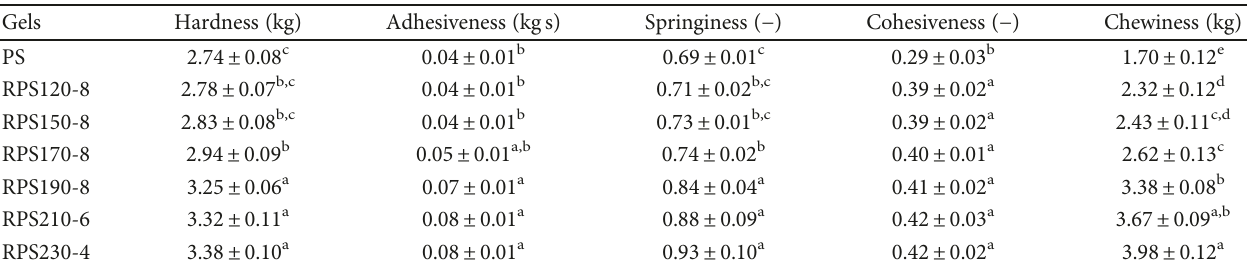
Figure 4: In fl uence of roasting conditions on the mechanical behaviour of the fi nal potato starch gels (G ′ (b) removal of the soluble fraction after starch roasting. Table 2: Texture parameters of tested potato starch gels (30% w / w ) roasted at di ff erent temperatures (120, 150, 170, 190, 210, 230 ° C). Gels Hardness (kg) Adhesiveness (kgs) Springiness ( − ) Cohesiveness ( − ) Chewiness (kg)